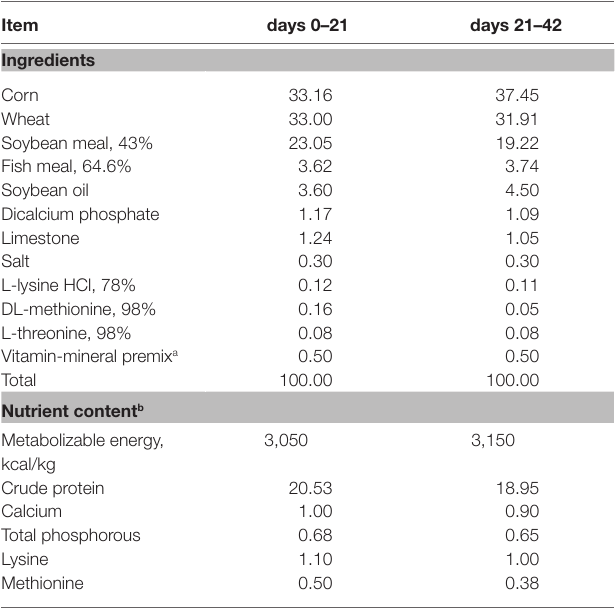
TABLE 1 | Composition and nutrient levels of basal diets (%, as-fed basis).